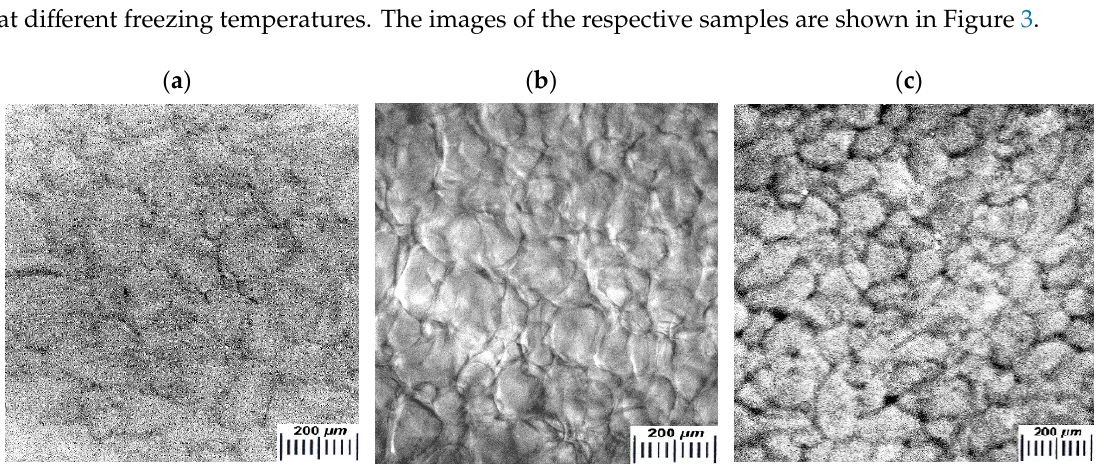
Figure 3. Micrographs (optical stereo microscope) of the water-swollen proteinaceous cryogels formed at − 15 ( a ), − 20 ( b ) and − 30 °C ( c ) (the proteins concentration in the initial solutions was 50 mg/mL for all the samples).